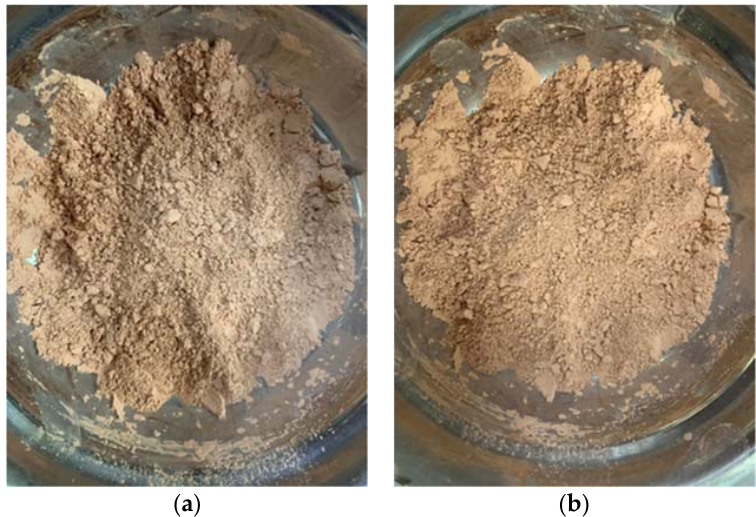
Figure 1. Coal ‐ based kaolin ( a ) and coal ‐ based metakaolin ( b ). Figure 1. Coal-based kaolin ( a ) and coal-based metakaolin ( b